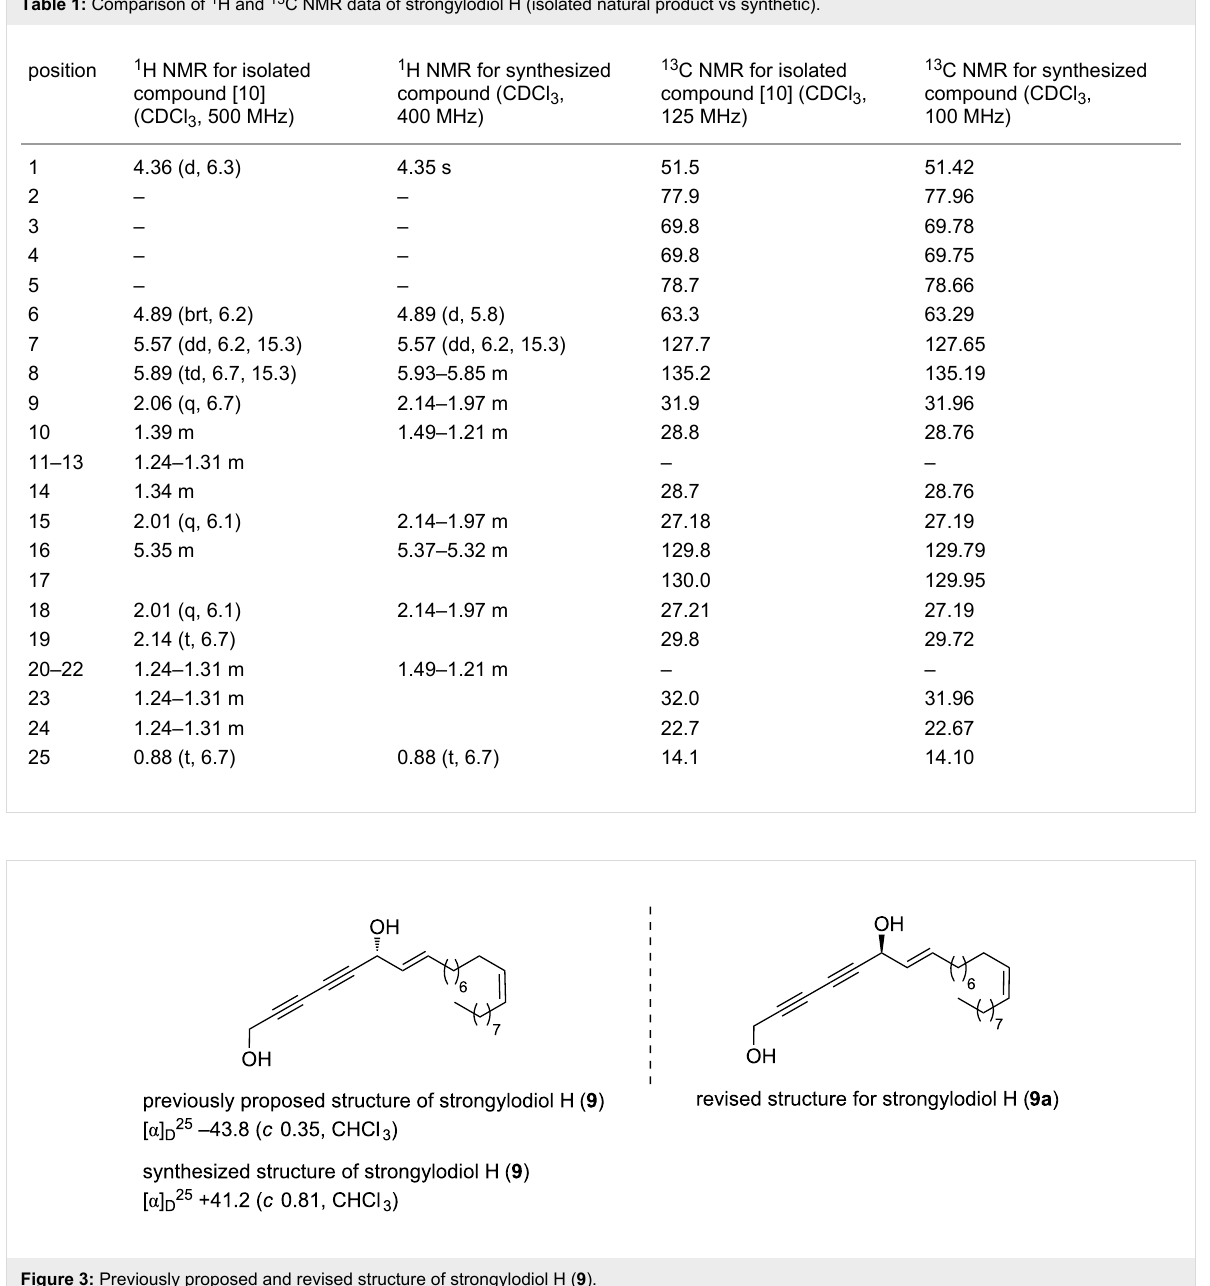
Table 1: Comparison of 1 H and 13 C NMR data of strongylodiol H (isolated natural product vs synthetic).